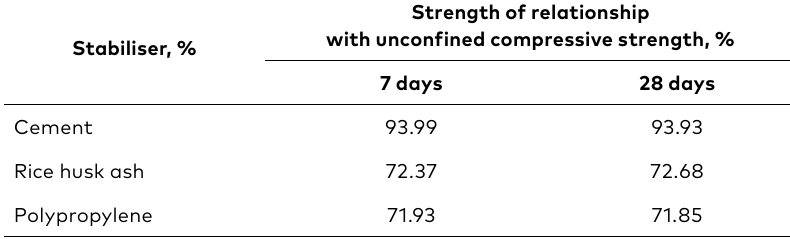
Table 6. The strength of the relationship between the unconfined compressive strength of 7 days of stabilised samples and concerning parameters Strength of Stabiliser, %